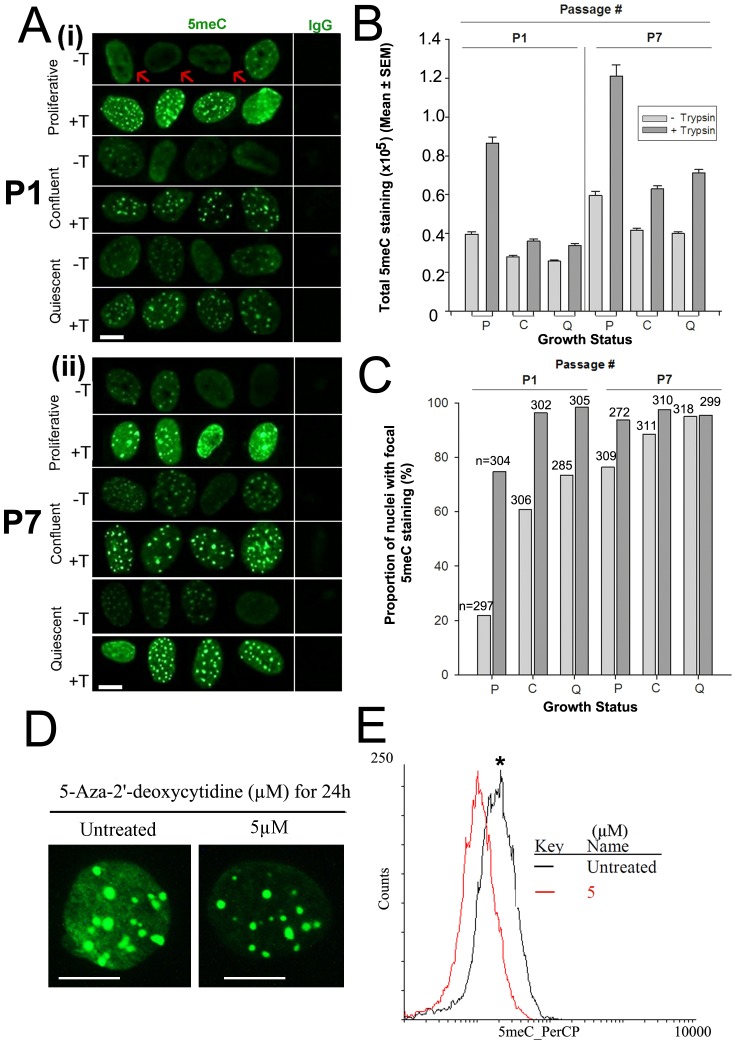
The effects of growth status on the pattern of cytosine methylation.
A Proliferative, confluent and quiescent cells at (i) passage 1 (P1) or (ii) passage 7 (P7) were stained with 5meC after 10 min acid (−T) or acid treatment followed by 1 min trypsin (+T). Scale bar 10 micron. Typical diffuse 5meC staining is shown by red arrows. B The total level of 5meC staining. Proliferative (P); Confluent (C); quiescent (Q). Growth status (p<0.0001) affected both the level of 5meC detected and the proportion of nuclei with focal 5meC and the use of trypsin (p<0.0001) affected the detection of those. C The proportion (%) of nuclei with focal 5meC staining. n, total nuclei analysed. Passage # (p<0.0001) affected both the level of 5meC detected and the proportion of nuclei with focal 5meC and the use of trypsin (p<0.0001) affected the detection of those. The results are from three independent replicates. D The effect of treatment of proliferative cells for 24 h with the 5 µM 5-aza-2′-deoxycytidine-2′-deoxycytidine on the level of 5meC staining of MEFs. Scale bar = 10 µm E The decrease in the staining levels of 5meC in MEFs after treatment with 5 µM 5-aza-2′-deoxycytidine-2′-deoxycytidine compared to control cells (Untreated) as detected by fluorescence activated flow cytometry (p<0.05). 5meC is tagged with a PerCP-conjugated antibody and detected at fluorescence channel-3. * p<0.05.